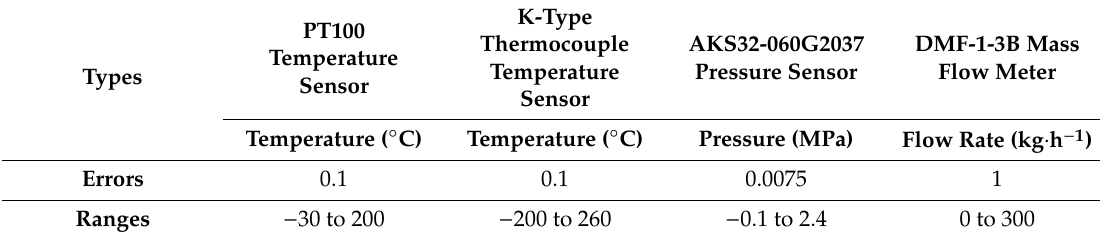
Table 2. Major sensors and their